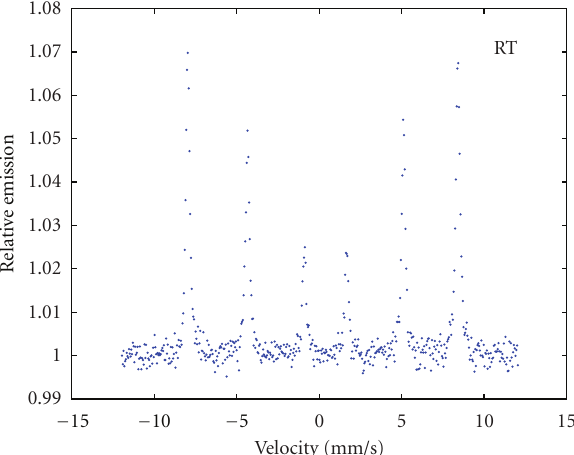
Figure 9: M¨ossbauer spectra of the TiO 2 :Fe, Sample 87 at room temperature